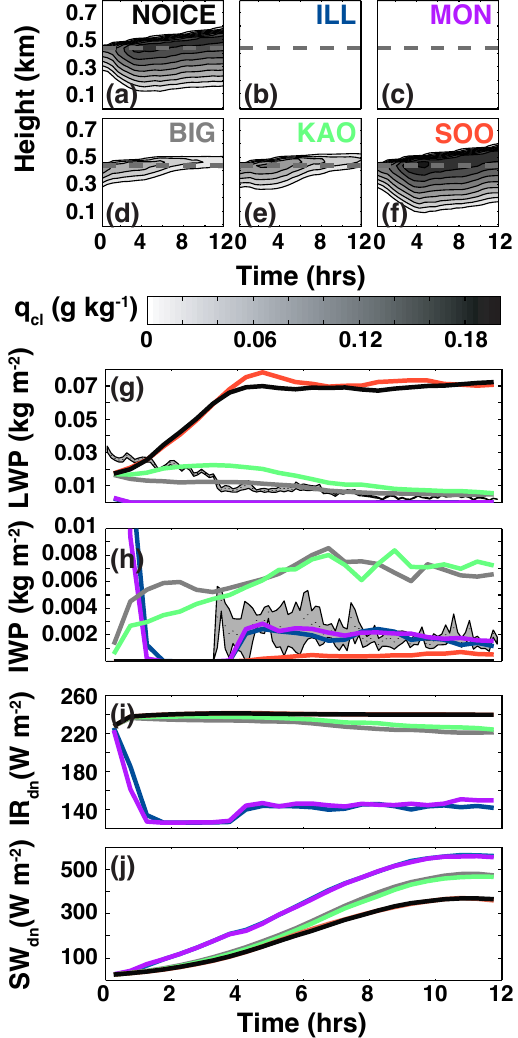
Fig. 6. An overview of simulation results assuming different insol- uble mass types. Included are domain-averaged time-height cross- sections of cloud water mixing ratio (a–f) , and time series of domain-averaged liquid water path (g) ice water path (h) , sur- face downwelling longwave radiation (i) , and surface downwelling shortwave radiation (j) . Grey shading in the liquid and ice water path plots represent the mean ± one standard deviation of observed values.